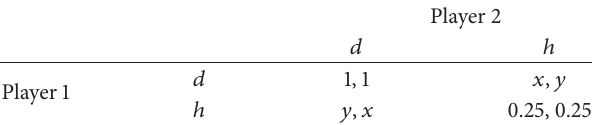
Table 1: The 2 × 2 conflict